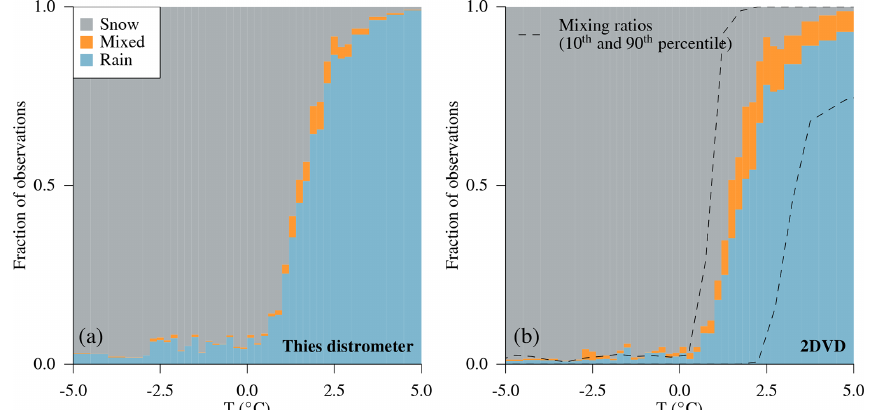
Figure 11. Relative frequency of the observed dominant precipitation phase by the Thies disdrometer (a) and the two-dimensional video disdrometer (2DVD, b ) as a function of air temperature during 2 years of measurements (2533h of precipitation). For the 2DVD, the mixing ratio of liquid precipitation obtained at different temperatures is indicated by the 10th and 90th percentile of its distribution (dashed